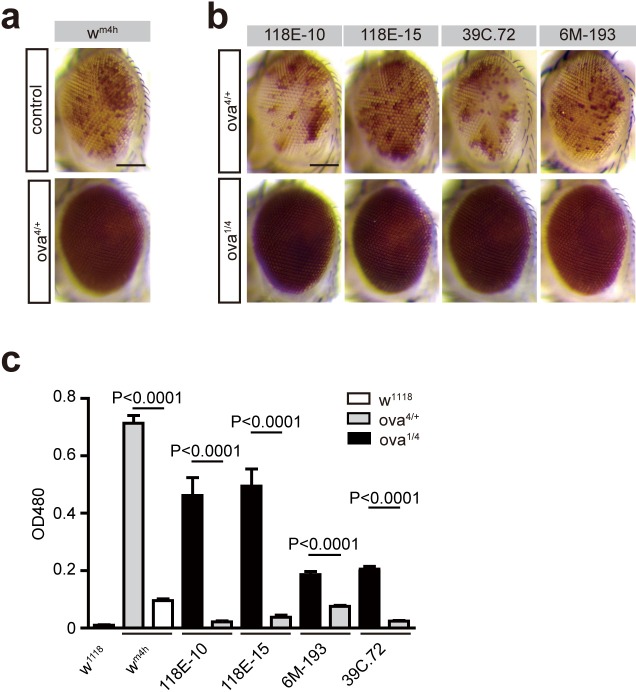
Ova acts as a suppressor of position-effect variegation (PEV).(a) Photographs showing representative eye pigments of adult females bearing X chromosome wm4h reporter plus wild-type and ova heterozygous alleles. (b) Photographs showing representative eye pigments of adult females bearing fourth chromosome PEV reporters plus heterozygous or trans-heterozygous of ova mutant alleles. (c) Quantitative measure of eye pigment levels of indicated genotypes by a spectrophotometer. Values are mean ± SEM.; n > 5. P values by two-tailed Student’s t-test.